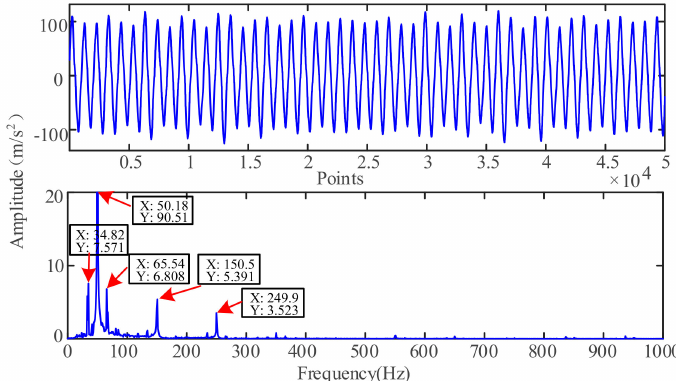
Figure 4. Time-frequency domain waveform of excitation signal of 2 mm leakage valve.